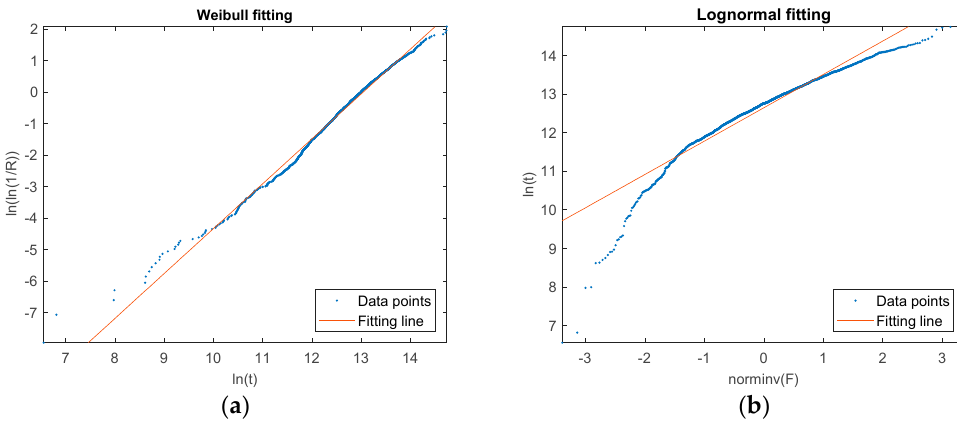
Figure 9. ( a ) The plotting of Weibull fitting; ( b ) The plotting of lognormal fitting.